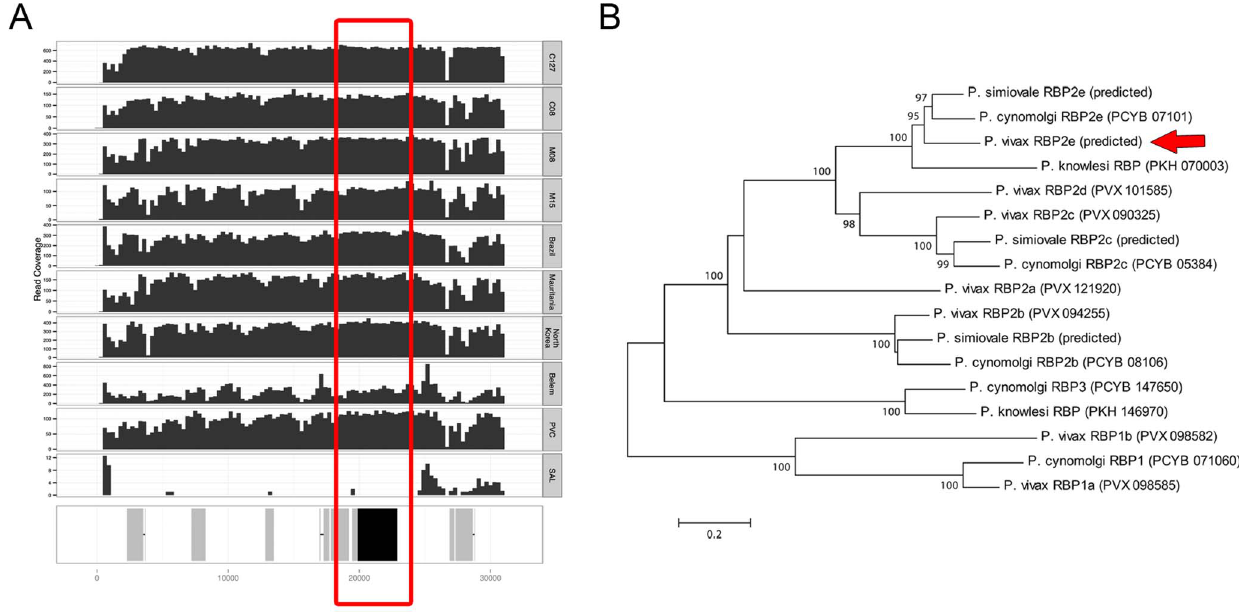
Figure 3. Novel P. vivax Reticulocyte-binding protein gene. ( A ) Next-generation sequencing read coverage along the , 30 kb contig assembled from the C127 sample. The samples displayed are, from top to bottom: C127, C08, M08, M15, Brazil I, Mauritania I, North Korea, Belem, Chesson and Salvador I. The bottom track shows, in grey, predicted protein coding genes and in black, the position of the predicted reticulocyte- binding protein gene (also highlighted by the red box). Note that there is no coverage of the contig in Salvador I. ( B ) Phylogenetic tree showing the relationships among protein sequences of P. vivax , P. cynomolgi , P. simiovale and P. knowlesi RBP genes. The position of the predicted P. vivax RBP2e gene is highlighted by the red arrow.